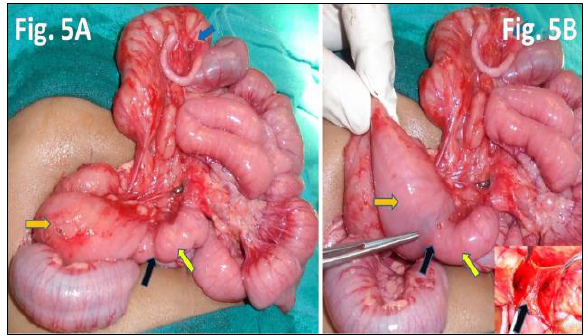
Figure 5: Intra-operative images depicts markedly dilated duodenum with increased wall thickness (orange arrow) till transition zone (black arrow) at DJ junction, and jejunum (yellow arrow) appears normal (Fig.5A); marked disparity in the size of the duodenum (orange arrow) and jejunum (yellow arrow). Inset image reveals web (black arrow) at DJ junction